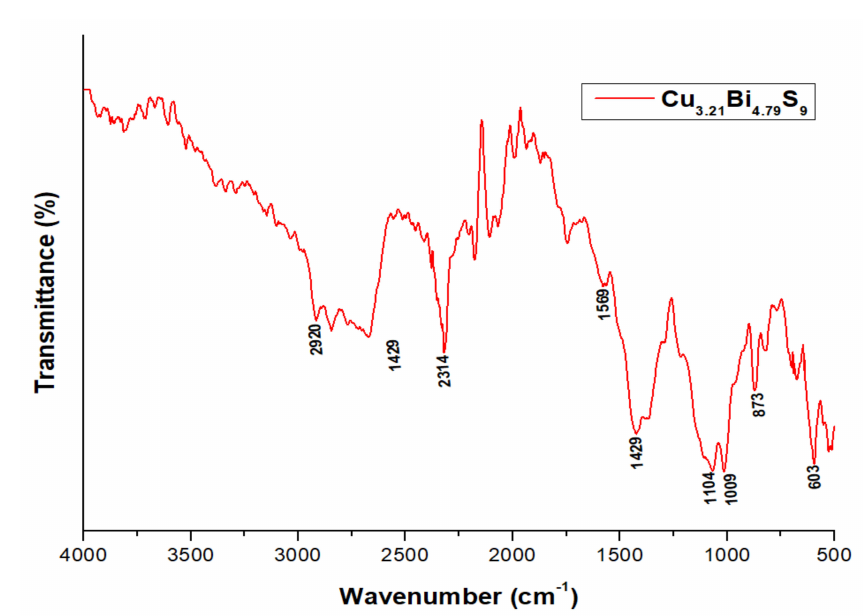
Figure A1. The FTIR spectrum of oleylamine-capped Cu 3.21 Bi 4.79 S 9 .